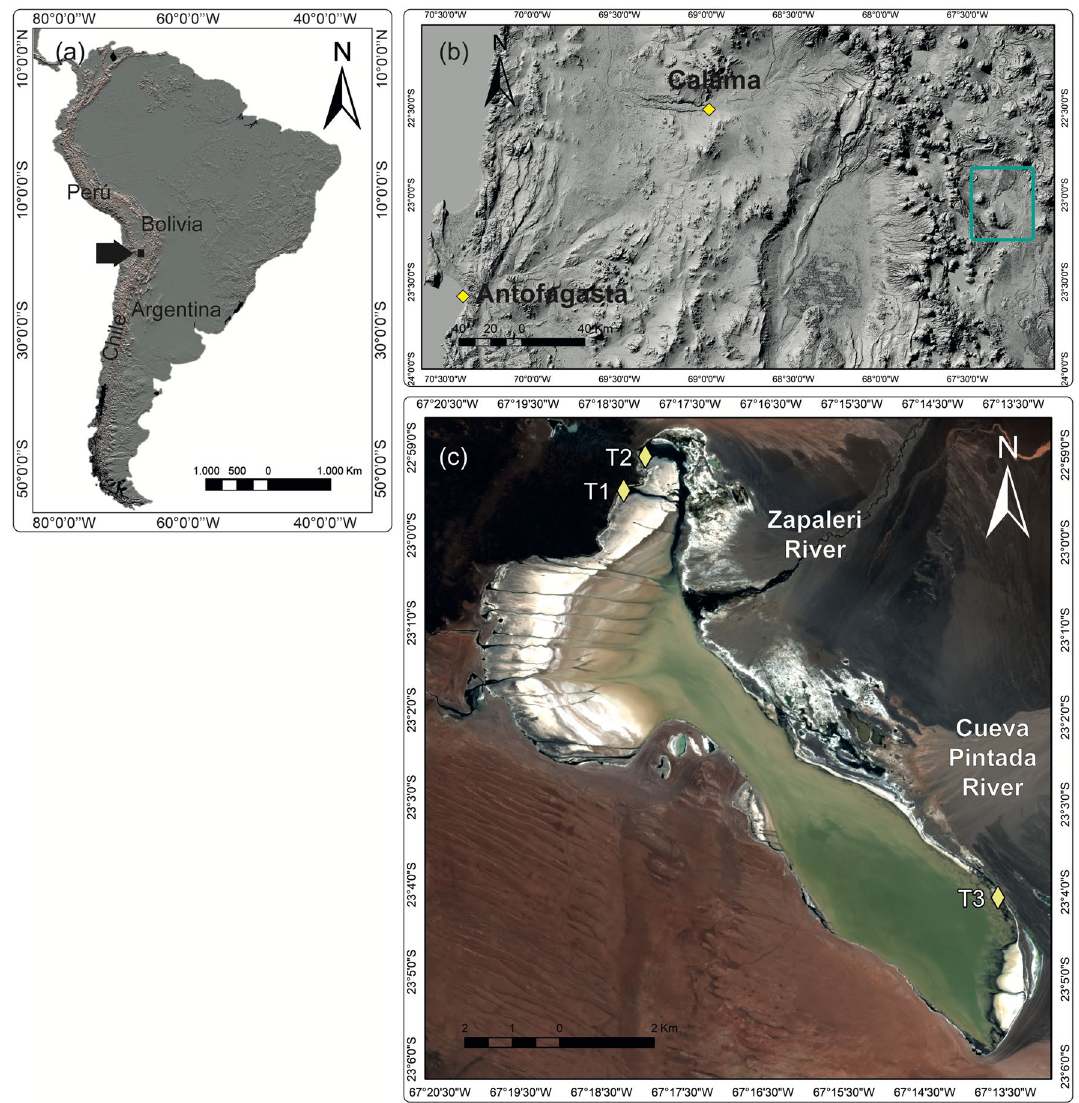
Figure 1. Salar de Tara. Location of Salar de Tara in Andean Altiplano-Puna, and sampling points distributed in the basin ( a ) ASTER Global Digital Elevation Model (GDEM) V.3 from 2006 was retrieved on 2020/06/16 from https:// lpdaac. usgs. gov, maintained by the NASA EOSDIS Land Processes Distributed Active Archive Center (LP DAAC) at the USGS Earth Resources Observation and Science (EROS) Center . https:// doi. org/ 10. 5067/ ASTER/ AST14 DEM. 003; ( b ) Sentinel-2A, European Space Agency (ESA) image courtesy of the U.S. Geological Survey. https:// doi. org/ 10. 5066/ F76W9 92G; ( c ) Shuttle Radar Topography Mission Products, Jet